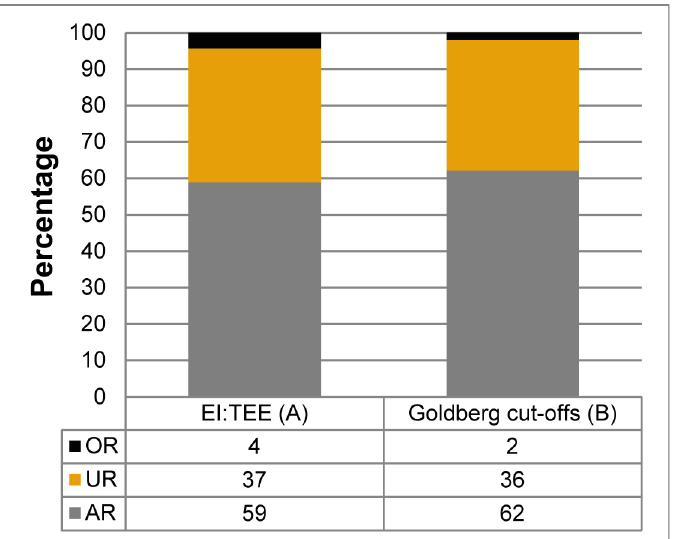
Fig 1. The percentage of AR, UR and OR, identified using two different approaches. AR, acceptable reporters; UR, under-reporters; OR, over-reporters; EI, energy intake; TEE, total energyexpenditure.(A) AR were definedas those within the 95% confidencelimits of the agreement betweenestimated EI from a web- basedfood recall (WebFR) and TEE calculatedbasedon accelerometer counts, combinedwith data on weight, sex or REE. AR had EI:TEE from 0.72–1.28,UR had EI:TEE < 0.72 and OR had EI:TEE > 1.28. (B) The Goldberg cut-off approachwas used, in which AR were definedas those having a reportedEI:REE within the 95% CL of agreement of their individual physical activity level (PAL) measured by accelerometers. UR and OR were definedas those under and over this 95% CL, respectively.